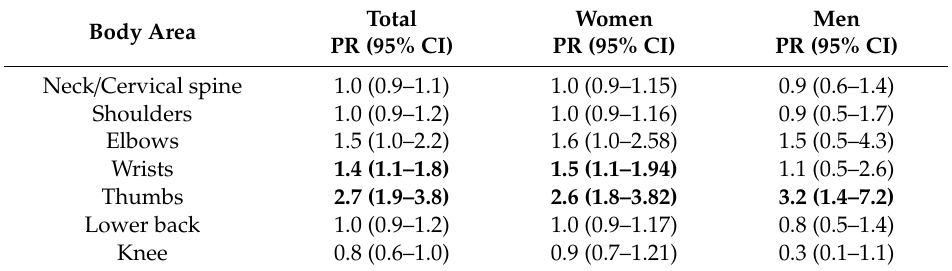
Table 3. Prevalence ratios of musculoskeletal complaints: occupational therapist (OT) vs. comparison group (CG; adjusted prevalence ratio (PR; 95%